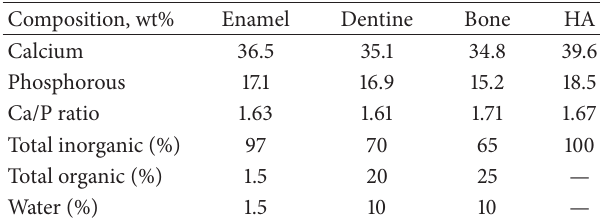
Table 1: Chemical and structural comparison of teeth, bone, and hydroxyapatite (HA).